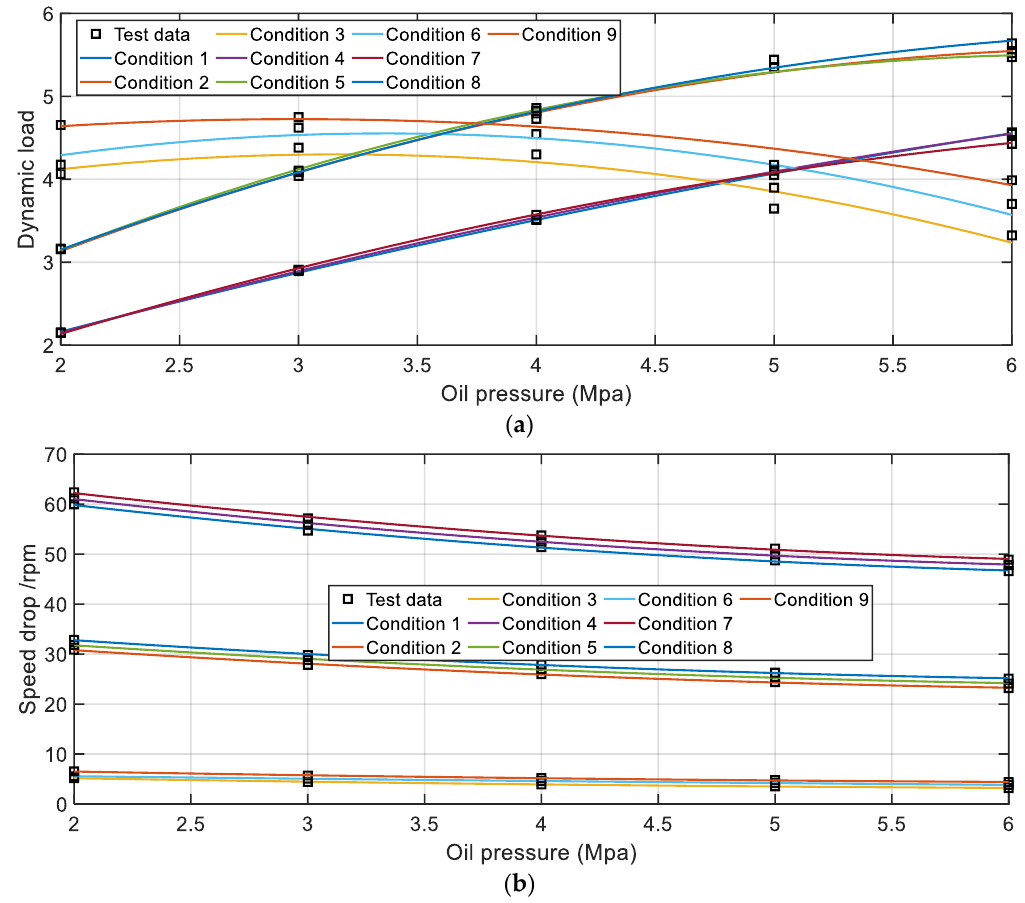
Figure 11. The new model of evaluation index after dimensionality reduction: ( a ) Dynamic load; ( b ) speed drop.